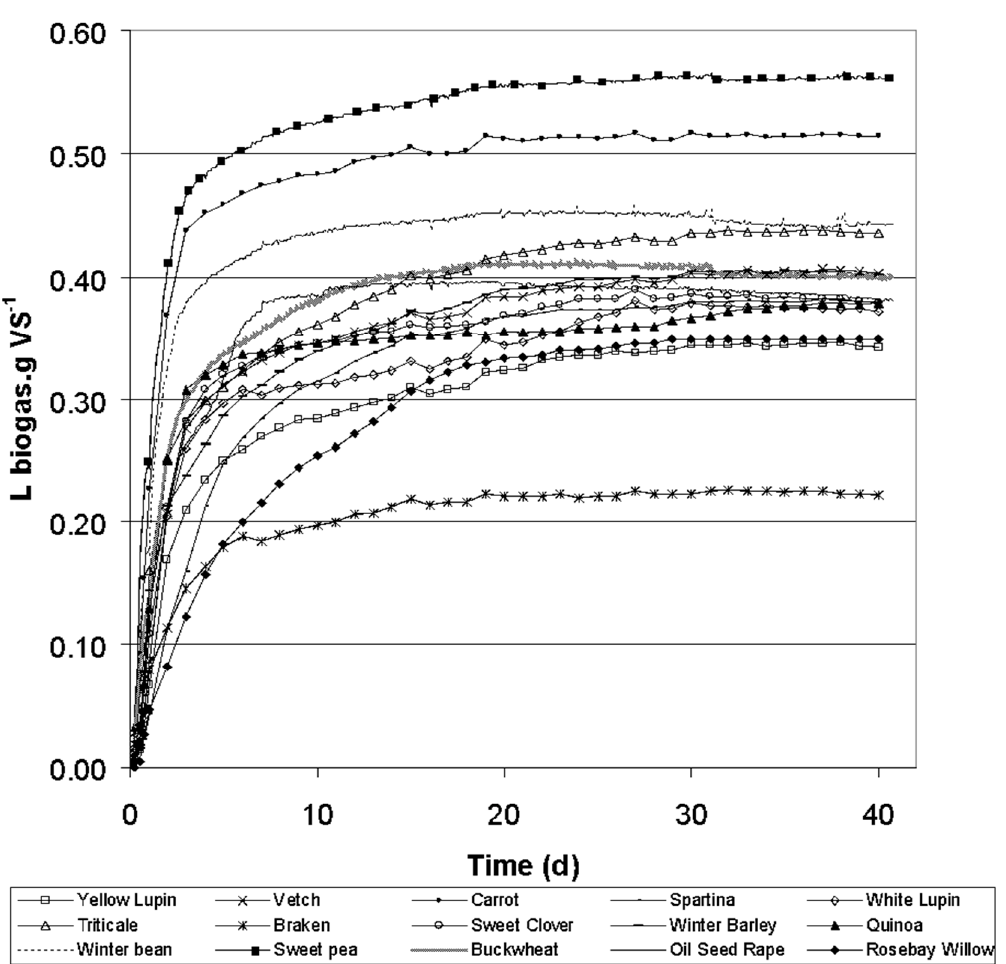
Figure 2. Net biogas accumulation during BMP assessment of fifteen plant samples, applying the optimized BMP